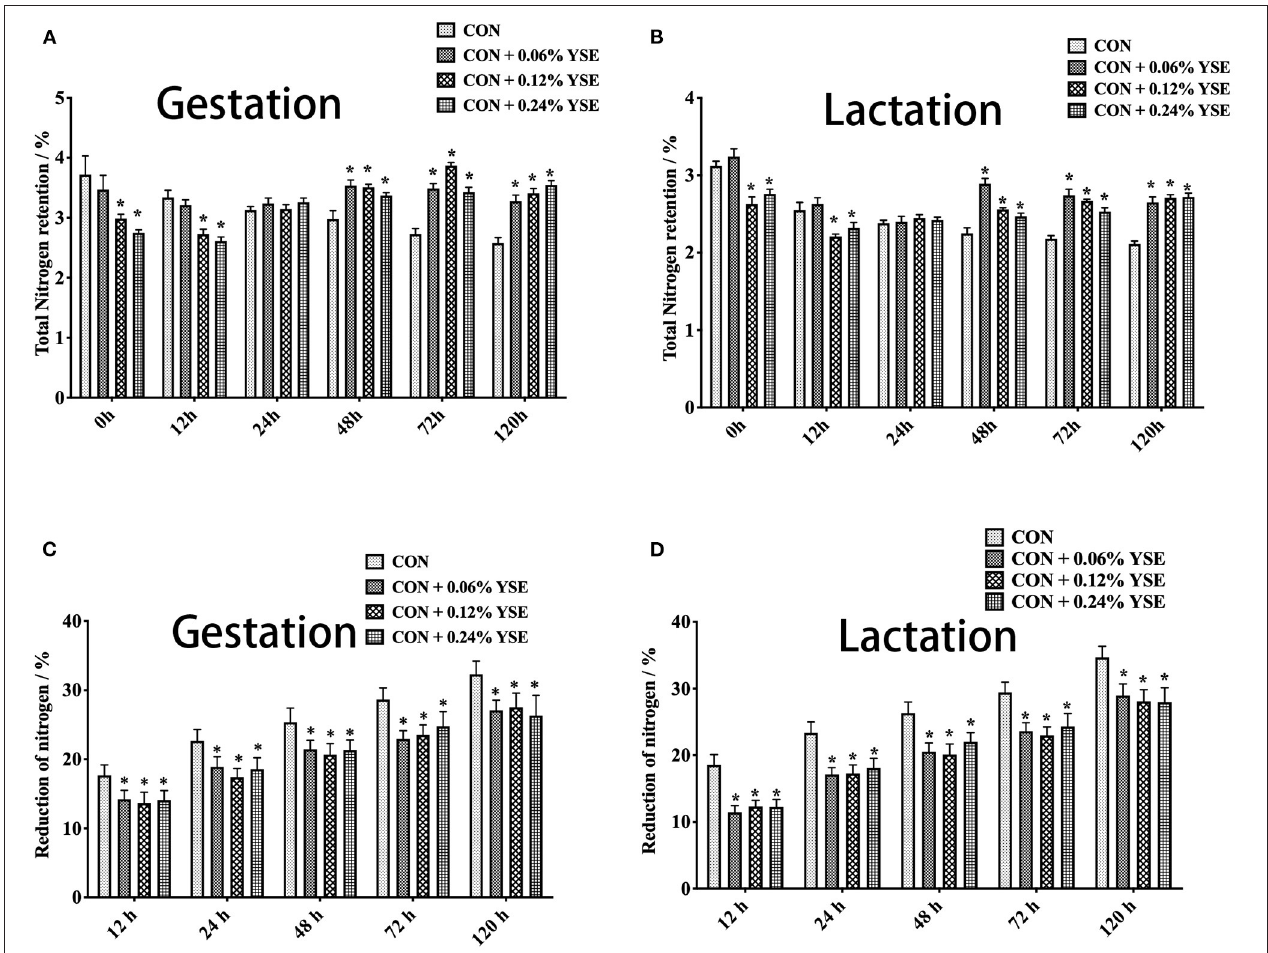
FIGURE 1 | The effect of dietary YSE supplementation on total nitrogen content and loss of nitrogen in manure of gestating and lactating sow during storage. (A) The effect of dietary YSE supplementation on total nitrogen content in manure of gestating sows during storage; (B) The effect of dietary YSE supplementation on total nitrogen content in manure of lactating sows during storage; (C) The effect of dietary YSE supplementation on loss of nitrogen in manure of gestating sows during storage; (D) The effect of dietary YSE supplementation on loss of nitrogen in manure of lactating sows during storage. * means significant